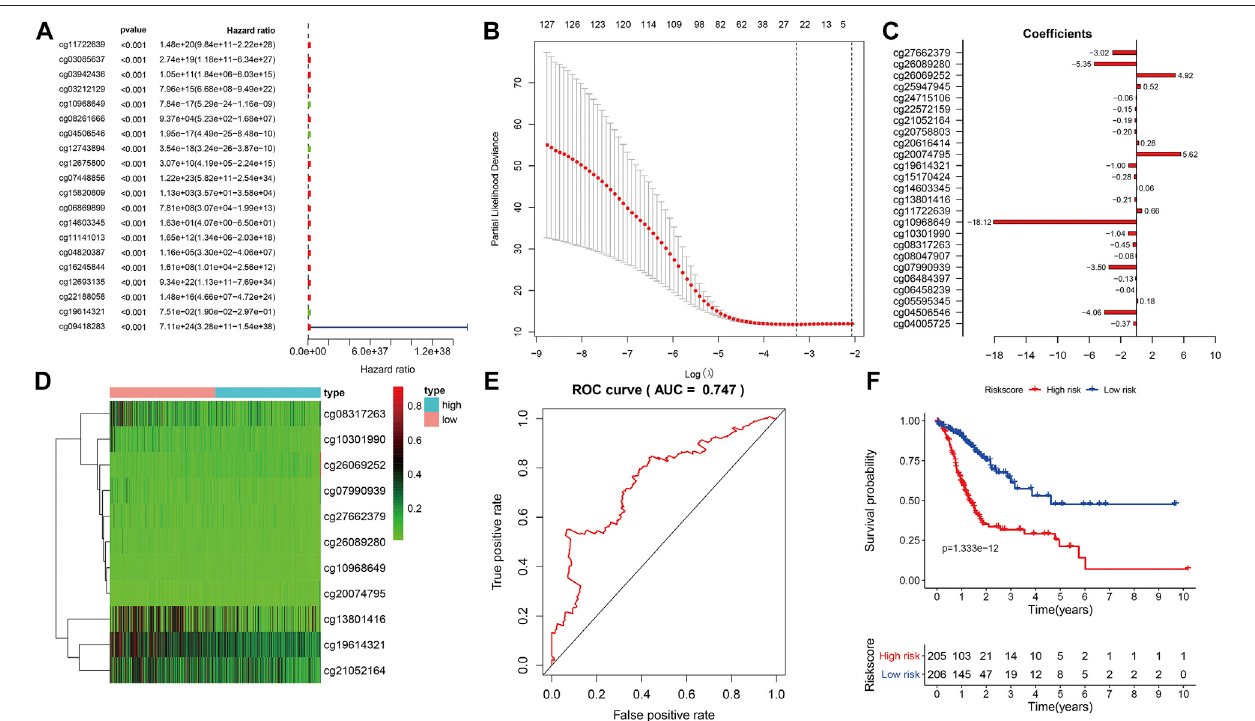
FIGURE 5 | Prognostic model based on differential methylation sites (DMSs). (A) Random forest plot of the top DMS with the most signi fi cant differences through univariate Cox proportional hazard regression analysis. (B) Results of LASSO regression analysis and 10,000 simulations. (C) Corresponding coef fi cient values of each DMS inLASSOregressionanalysis. (D) DNAm heatmapofDMSs inthelow-risk andhigh-riskgroupswithincreasingprognostic riskscore value. (E) Receiver operating characteristics curve analysis of the prognostic model. (F) Kaplan – Meier survival analysis of DMSs related to prognostic model, abscissa for survival time, ordinate for survival rate, blue curve for low-risk patients, red curve for high-risk patients. The number of high-risk and low-risk patients at each time point are located on the bottom axis of the graph.